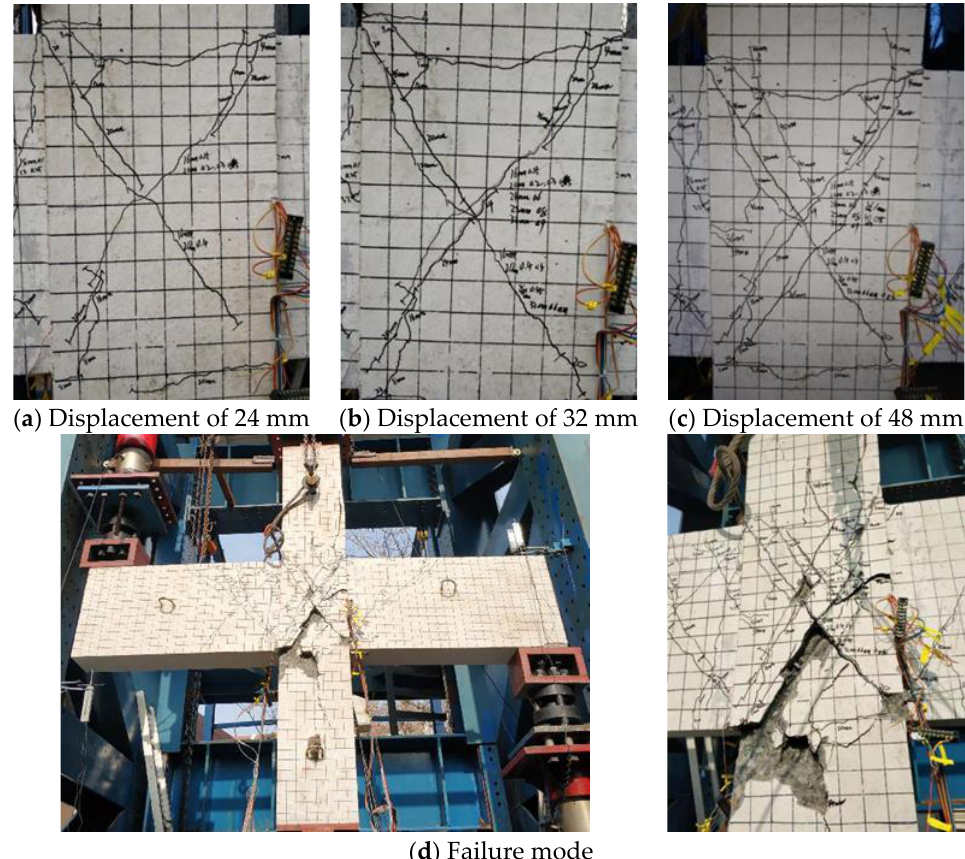
Figure 12. Crack development and failure of specimen ZJ-2.